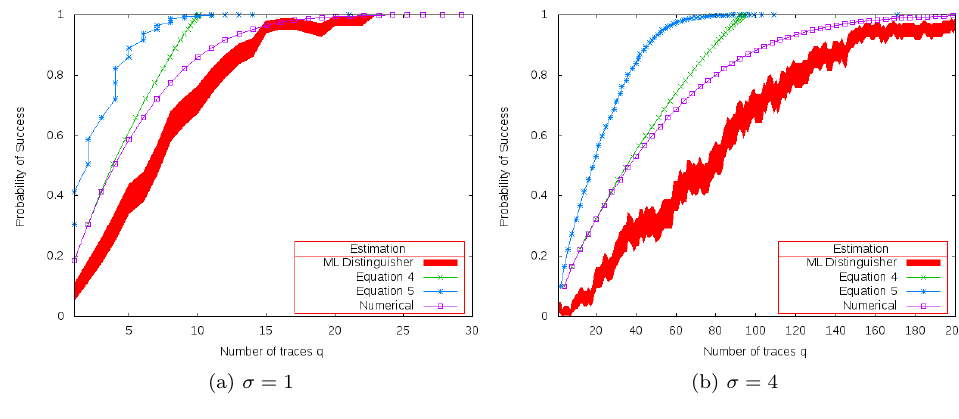
Figure 6: Success rate for a Hamming weight